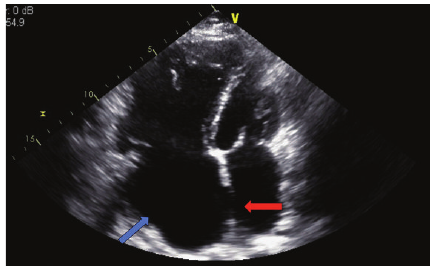
Figure 4: Echocardiography showing enlarged right ventricle and right atrium (blue arrow) with sinus venosus defect (red arrow).